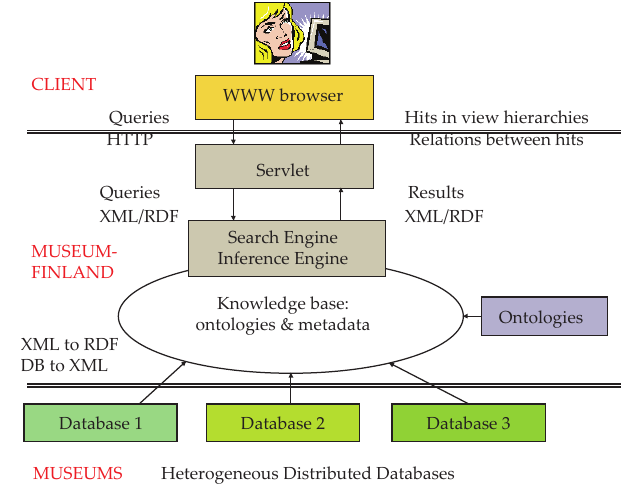
Figure 11. Architecture of the semantic portal “MuseumFinland” as shown in Hyvönen et al. [35]. Local database contents are merged and made available for query access, which can be used by diverse applications and users. Reproduced from Hyvönen et al. [35]. Copyright 2005